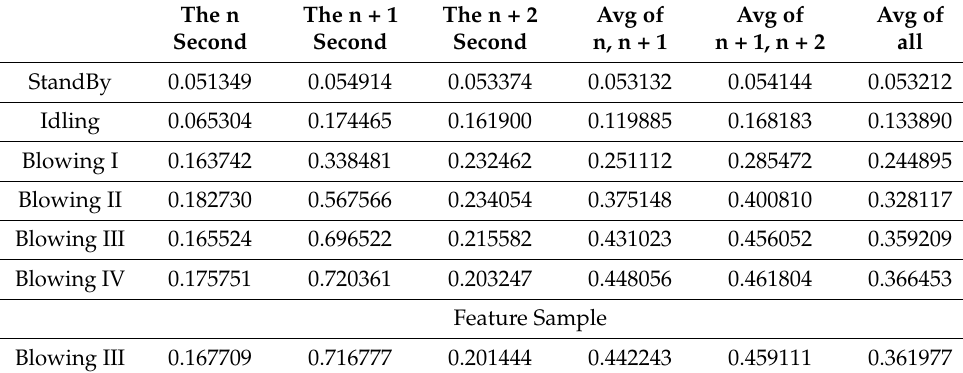
Table 6. Conditional probability of blowing